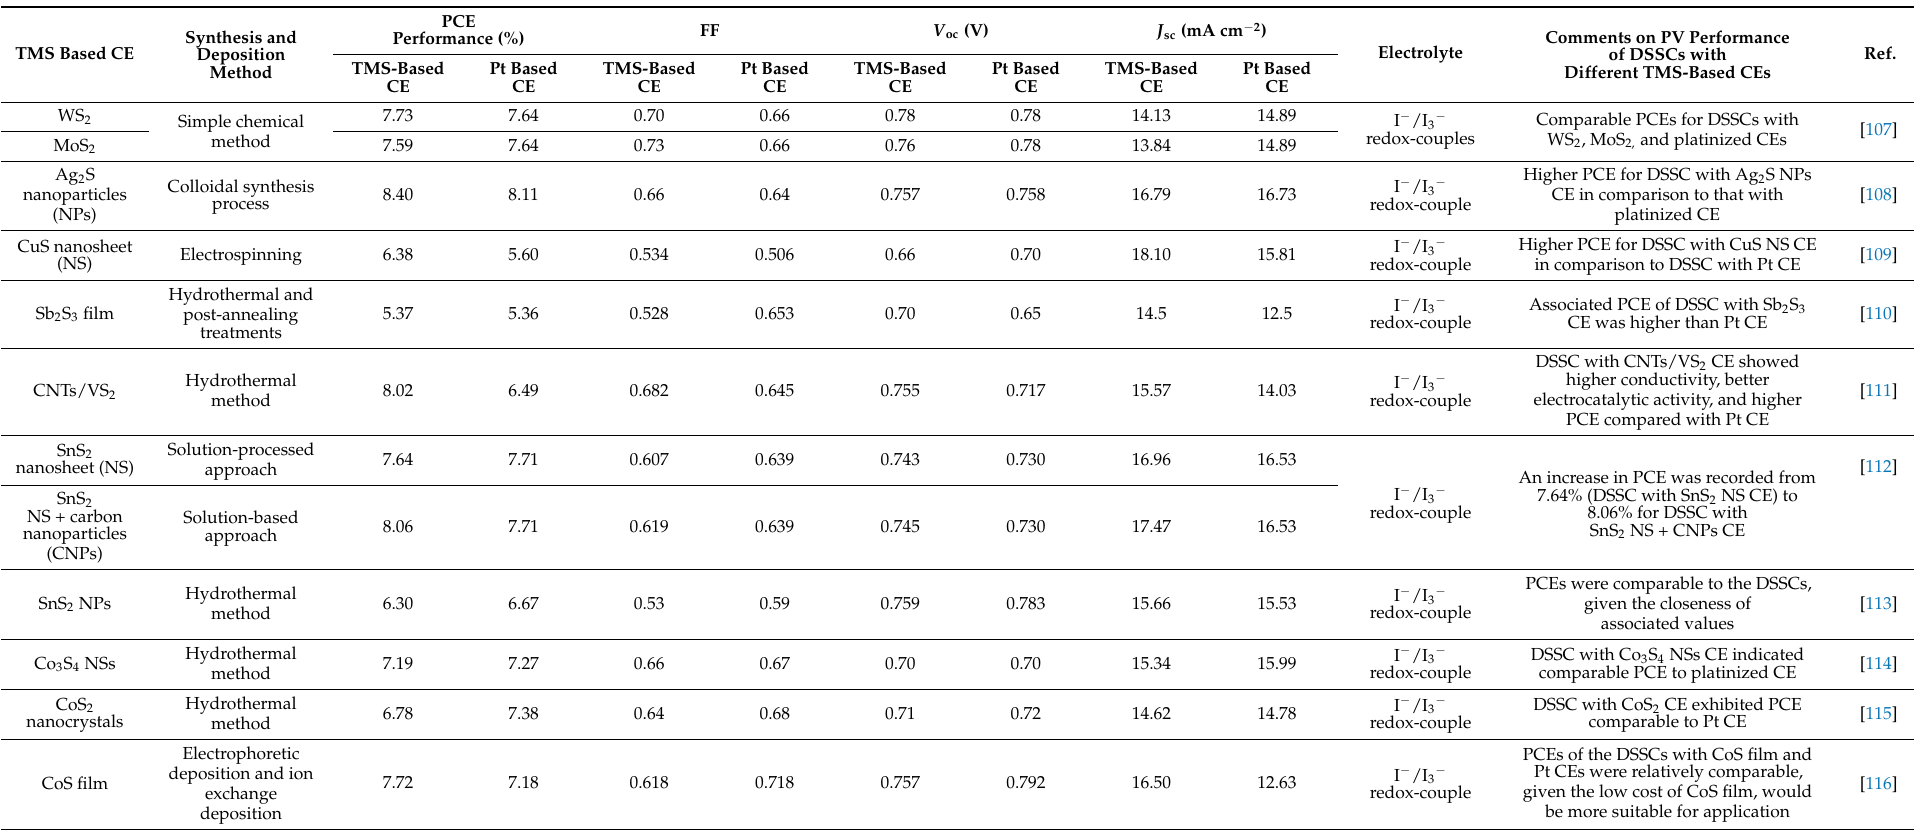
Table 1. Summary of 0TMS-based CEs synthesized and applied in DSSCs. The resulting PV performance (PCE, FF, V oc , and J sc ) values of DSSCs with TMS-based CEs are compared to those of DSSCs with Pt-based